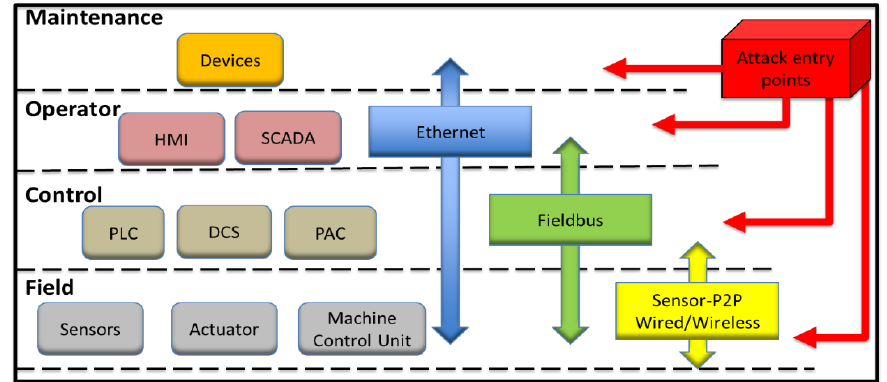
Figure 4. Legacy production machinery real-time monitoring system attack entry points. SCADA: Supervisory control and data acquisition; DCS: Distributed control systems; PAC: Programmable automation controllers; P2P: Peer-to-peer.